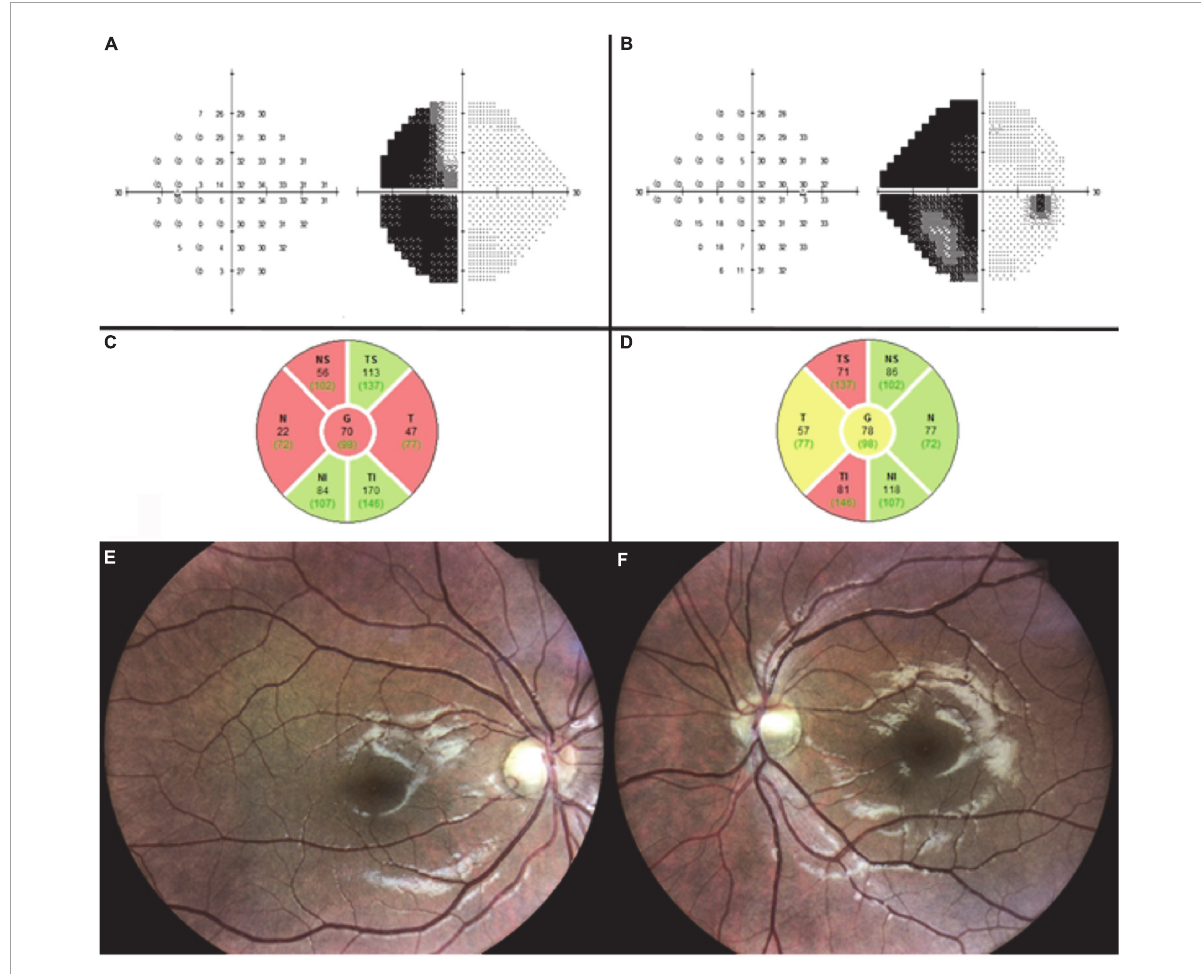
FIGURE1 Case 1. Ten months after traumatic injury, automated perimetry shows unchanged left homonymous hemianopia in the left (A) and right (B) eyes. OCT shows RNFL loss in the left temporal and nasal quadrants (C) and the right superior and inferior quadrants (D) . Fundus imaging 3 years after injury shows right optic disc temporal pallor (E) and left optic disc bow-tie atrophy (F)